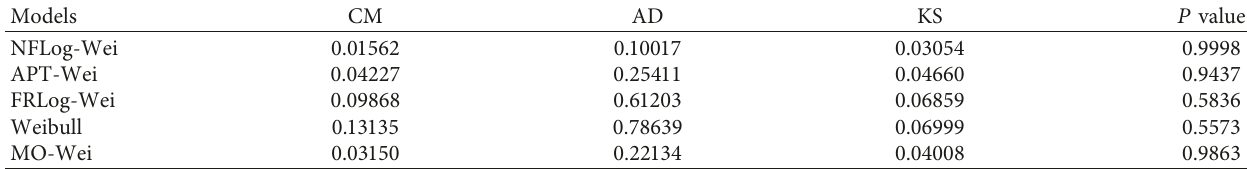
Table 11: The values of CM, AD, KS, and P value of the fitted models for Data